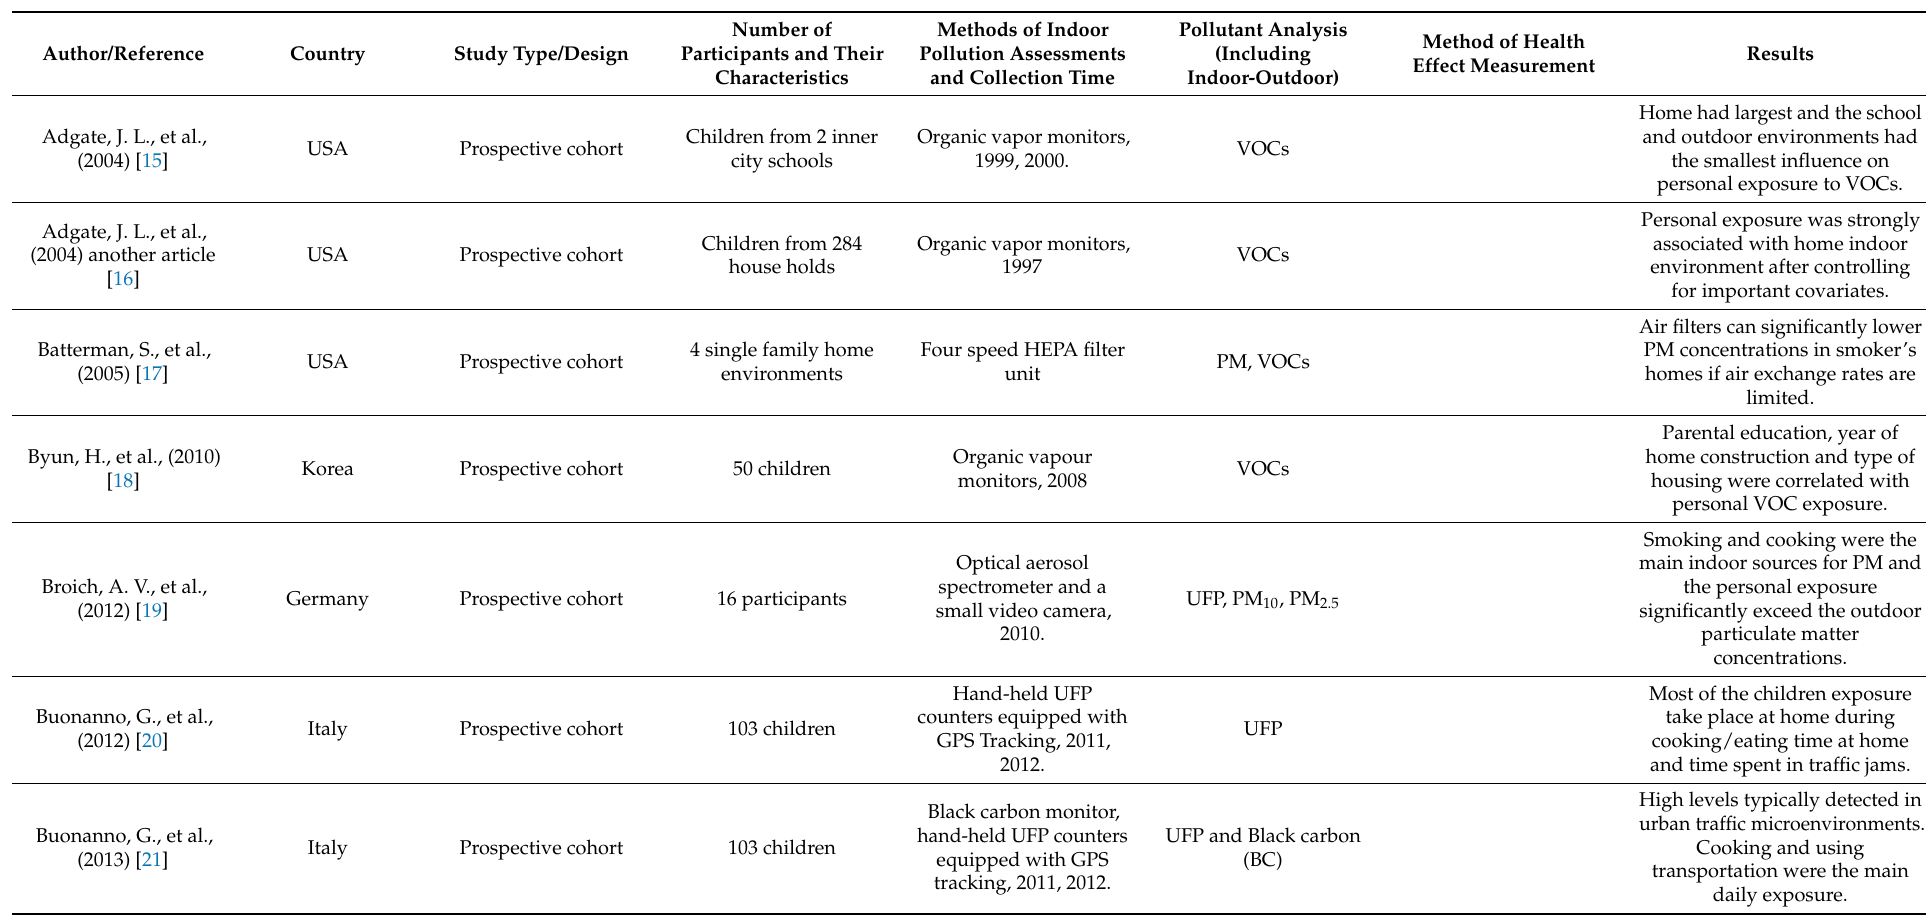
Table 2. Overview of the characteristics of the studies included (in alphabetical order of the first author of each